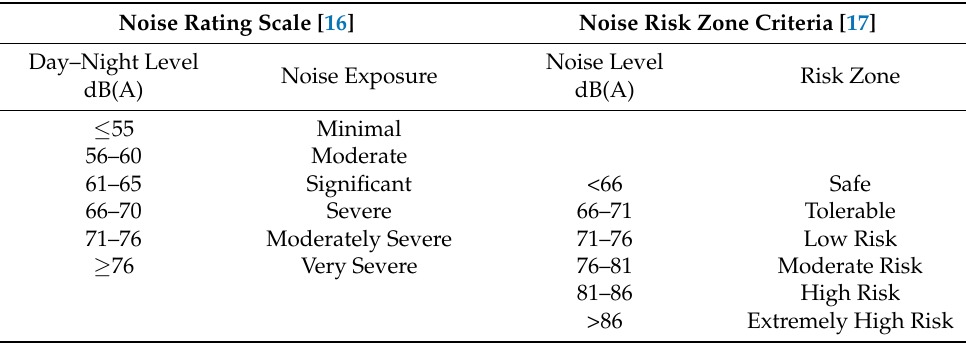
Table 1. Noise level scale for categorizing noise exposure and noise risk